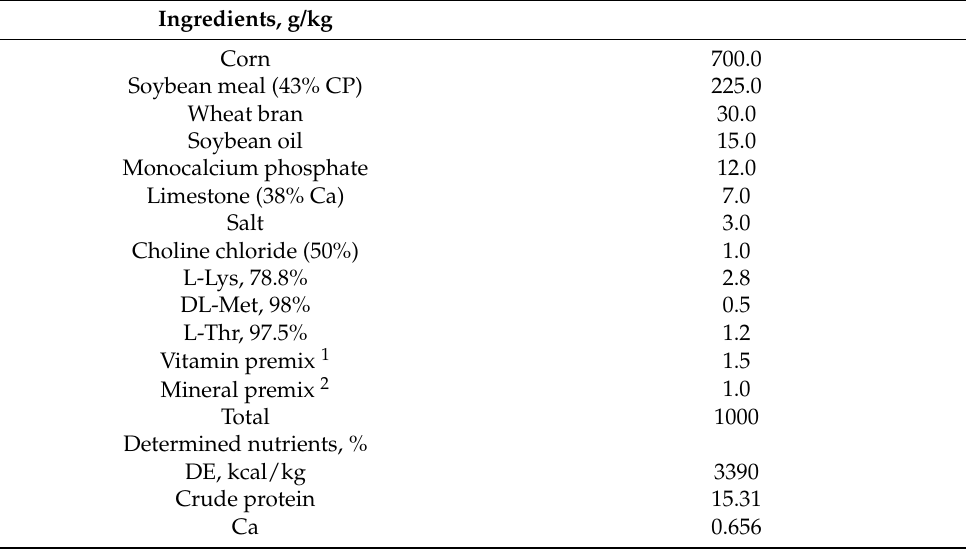
Table 1. Ingredient and chemical composition of